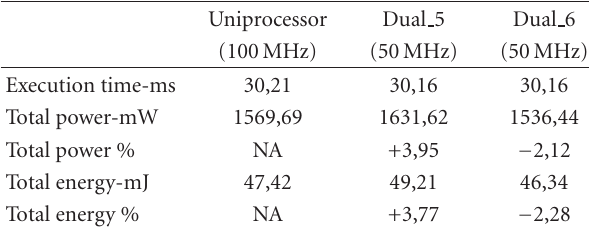
Table 15: DIALIGN power and energy